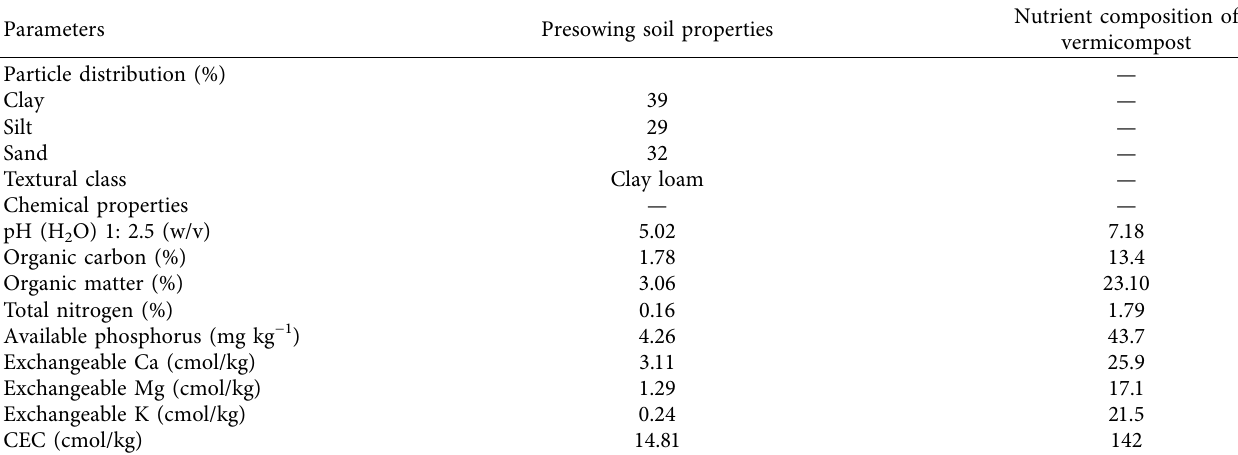
Table 1: Vermicompost nutrient composition and the physicochemical features of the study site soil in Guto Gida, Western Ethiopia. Parameters Presowing soil properties